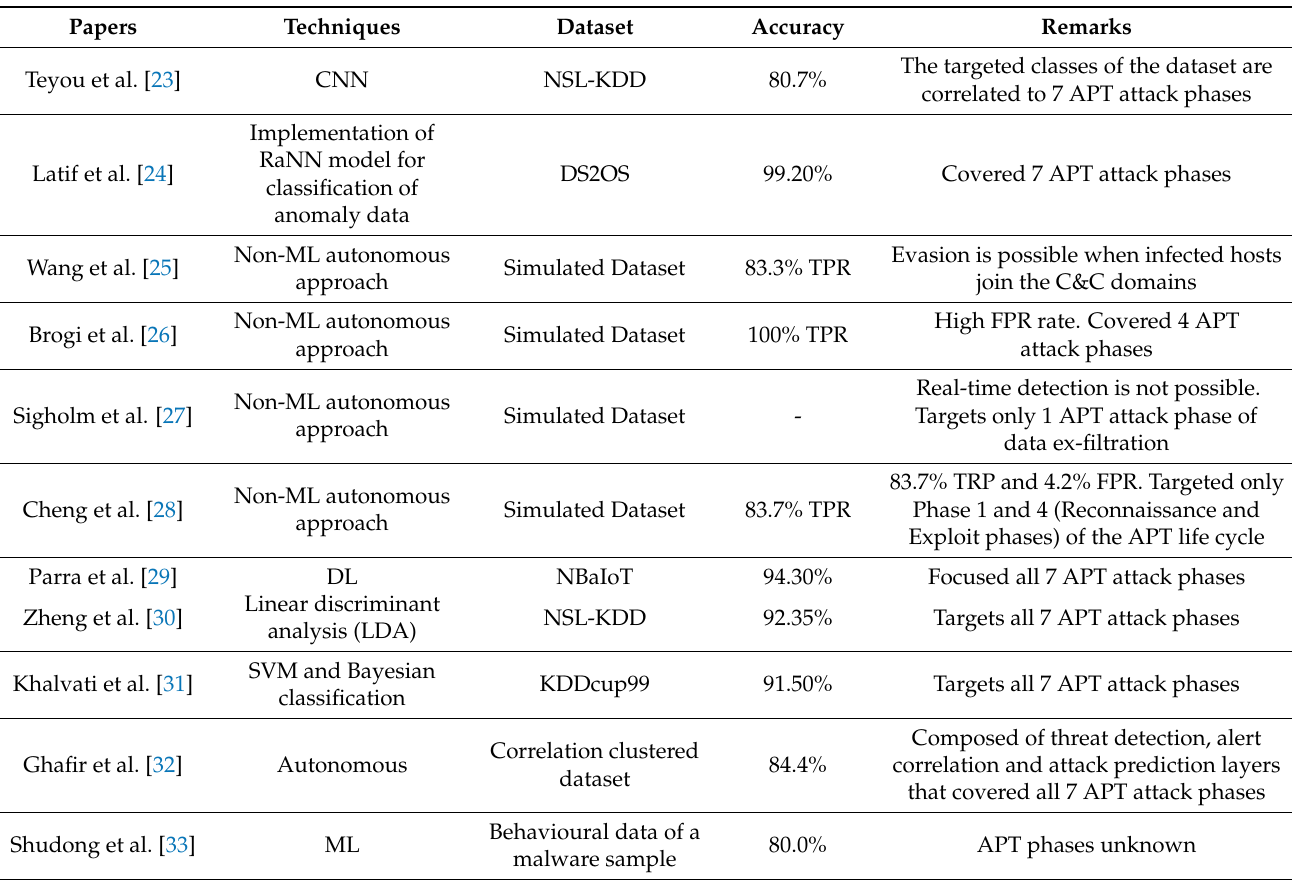
Table 1. Summarized related